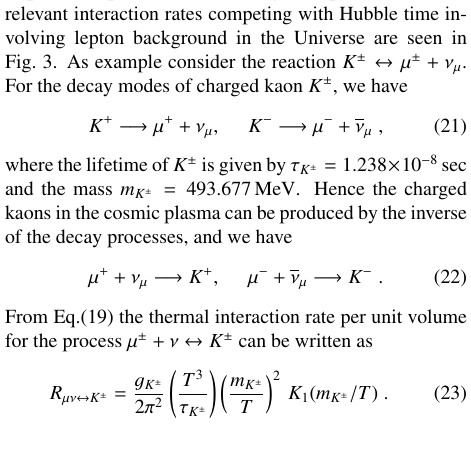
The freeze-out condition, τ µν where the relaxation reaction time µ ± + ν µ slower compared to the Universe expansion, and thus de- tailed balance in this reaction cannot be maintained, is near T K